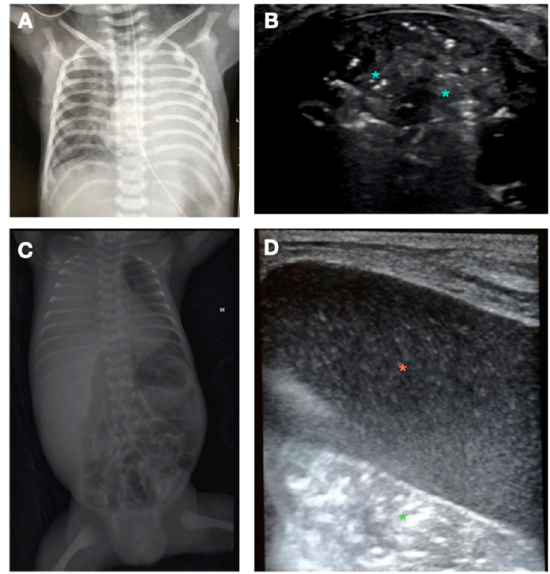
Figure 5. Detection of complications at CPUS. ( A , B ) Patient 1. ( A ) Chest X-ray from a patient with high oxygen requirement on mechanical ventilation showing left lung whitening. ( B ) Lung ultrasound (LUS) shows massive left lung consolidation with air bronchogram (light-blue asterisks). ( C , D ) Patient 2. ( C ) Chest X-ray from another patient with sudden deterioration showing right lung whitening. ( D ) Lung ultrasound (LUS) shows pleural effusion (red asterisk) with collapsed underlying lung (green asterisk).